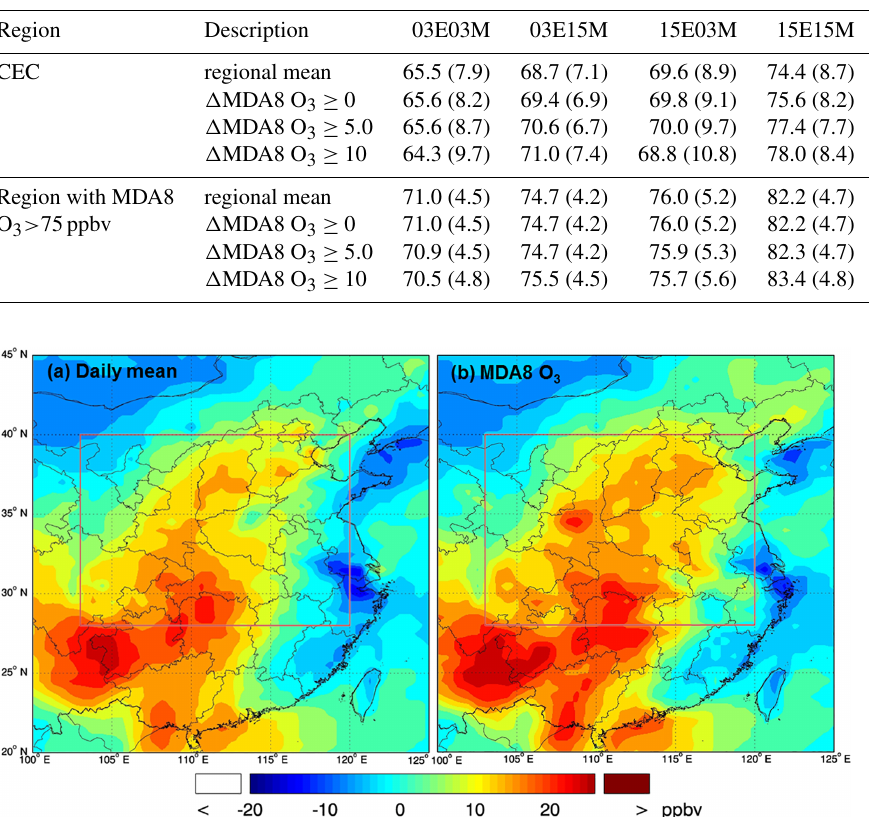
Table 2. Monthly mean (standard deviation) MDA8 O 3 over CEC based on four model simulations. (cid:49) MDA8 O 3 represents the difference in MDA8 O 3 concentrations between the 2015 standard simulation and 2003 standard simulation: (cid:49) MDA8 O 3 = MDA8 O 3 (2015) – MDA8 O 3 (2003). MDA8 O 3 > 75ppbv indicates the region of MDA8 O 3 exceeding the Level II National Ambient Air Quality Standard (75ppbv) in July 2015.